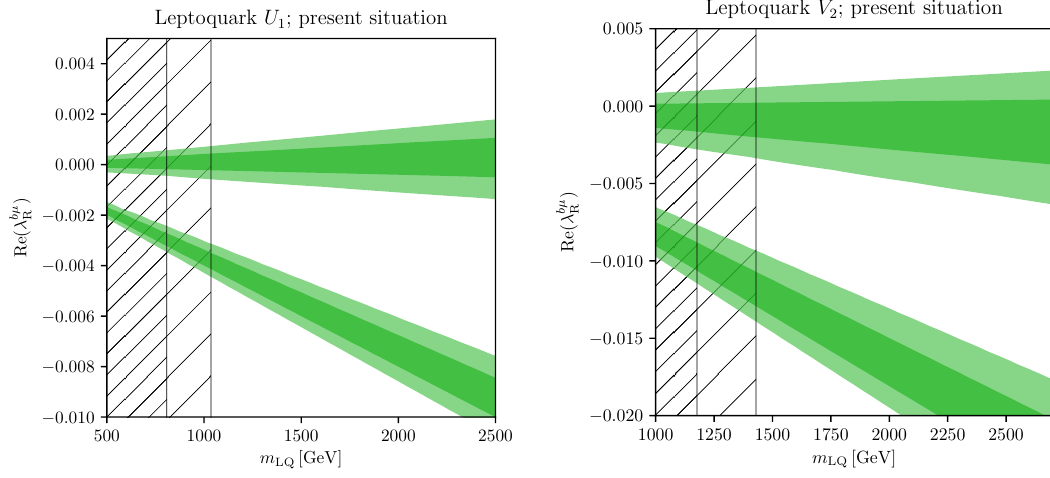
Figure 7 . The currently allowed parameter regions in the mass vs. coupling plane for the LQs U 1 ( left ) and V 2 ( right ) in the scenarios (6.9) and (6.10). Inside the dark and light green bands, the present value of the experimental branching ratio (3.4) is reproduced at 1 and 2 (cid:27) , respectively. The black //-hatched regions show the exclusions from present direct searches. The more densely hatched region corresponds to minimal LQ production, while the more coarsely hatched region is for YM-like